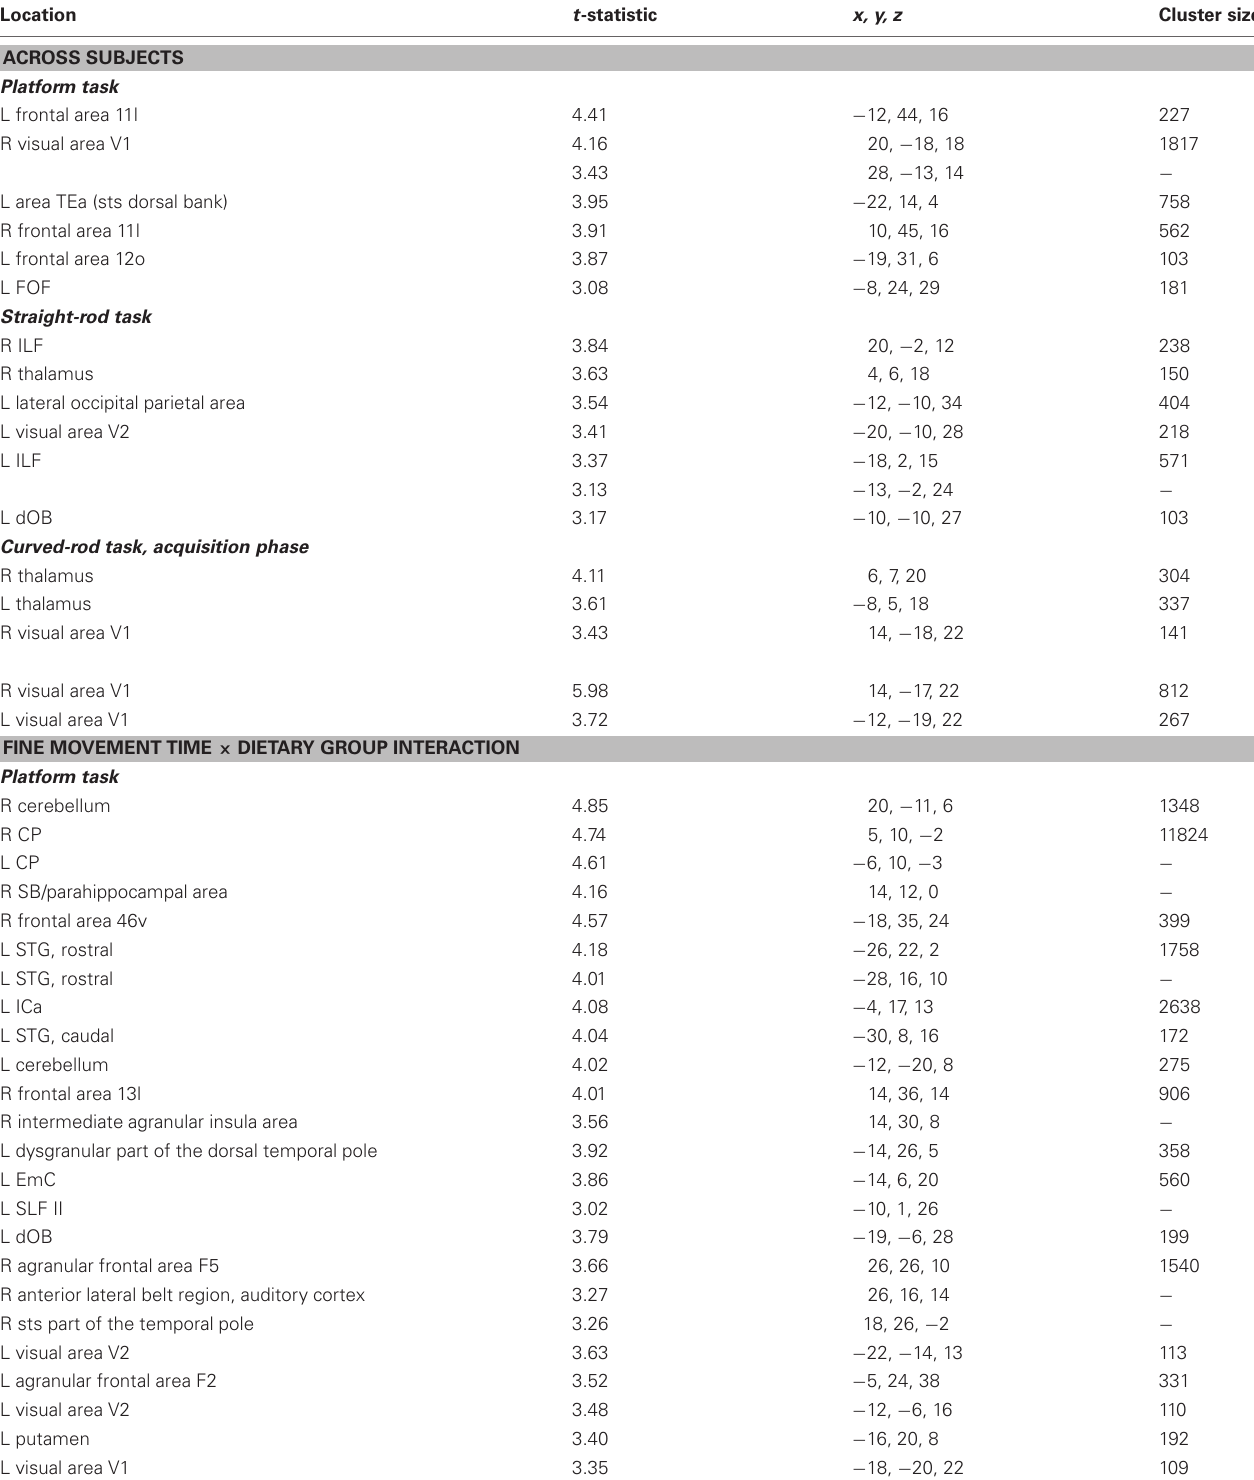
Table A5 | Regions where fine movement time was significantly correlated with mean diffusivity in voxel-wise analyses across subjects and between dietary